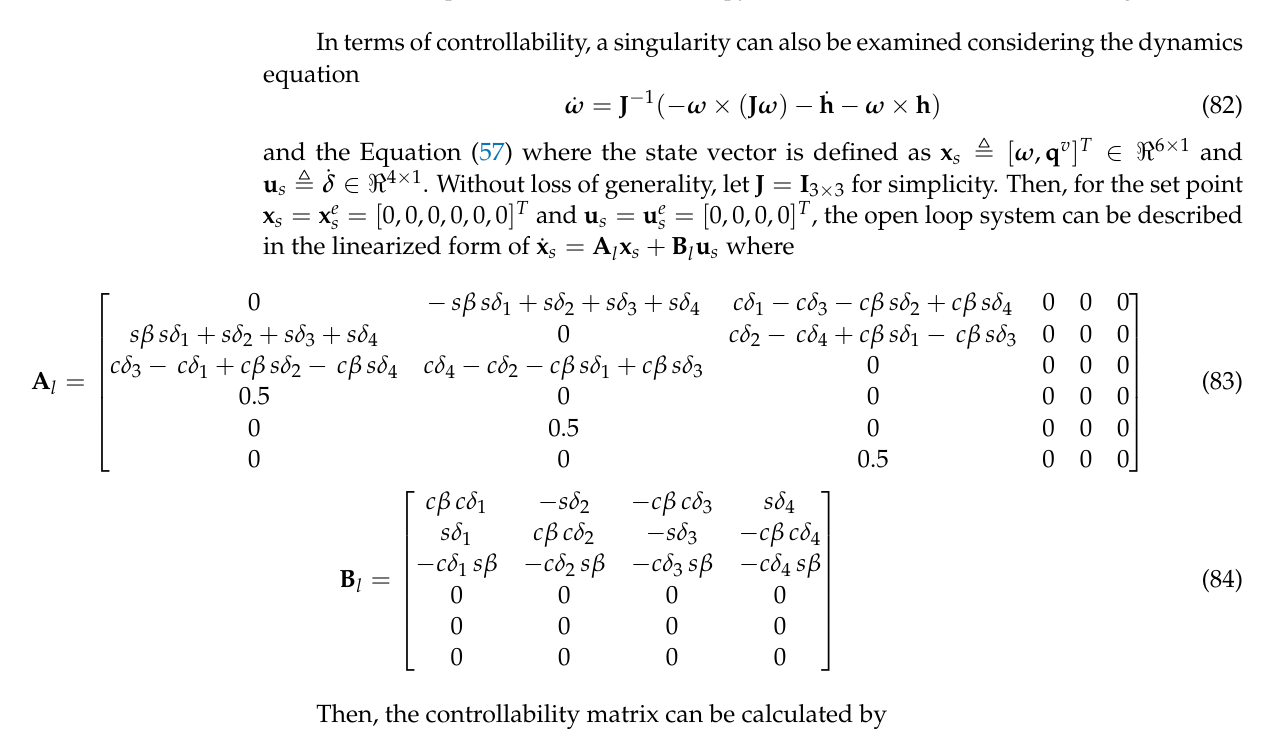
Figure 4. Visual repsresentation of the 4-CMG pyramid cluster at δ = [